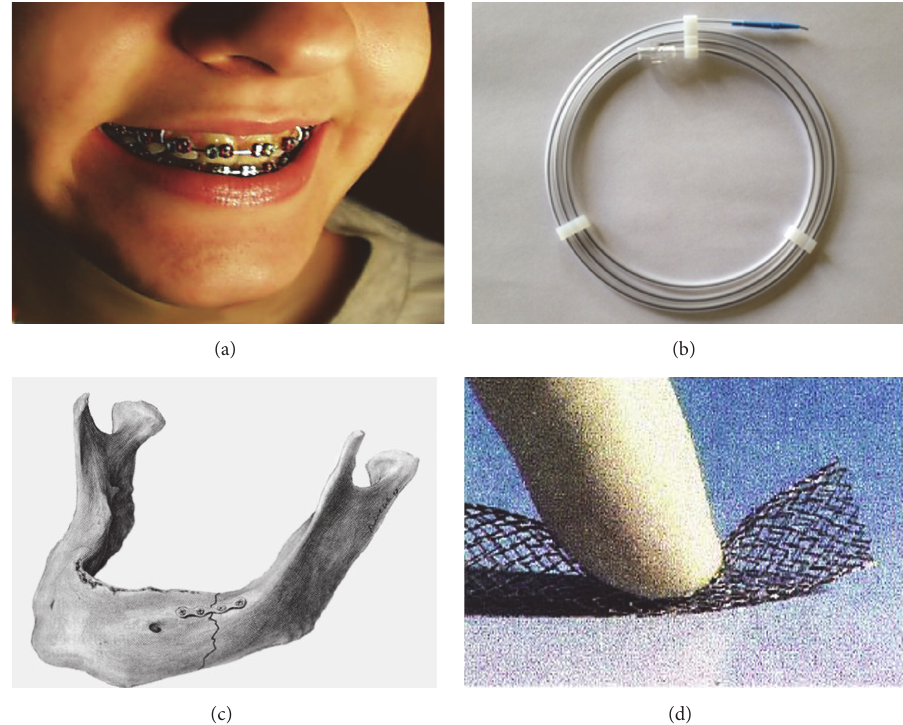
Figure 4: Biomedical applications of nitinol. (a) Orthodontic arch wire. (b) Guided wire. (c) Bone fixation. (d)